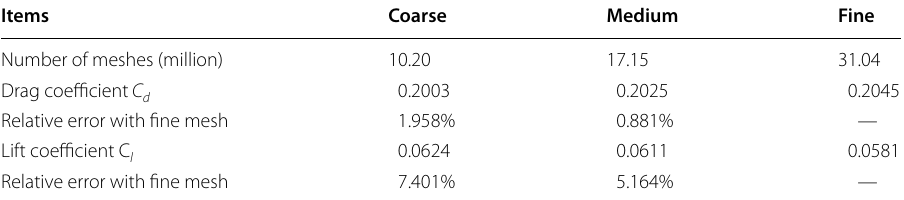
Table 1 The drag coefficient C of the maglev train under different mesh configurations d Items Coarse Medium Fine Number of meshes (million)